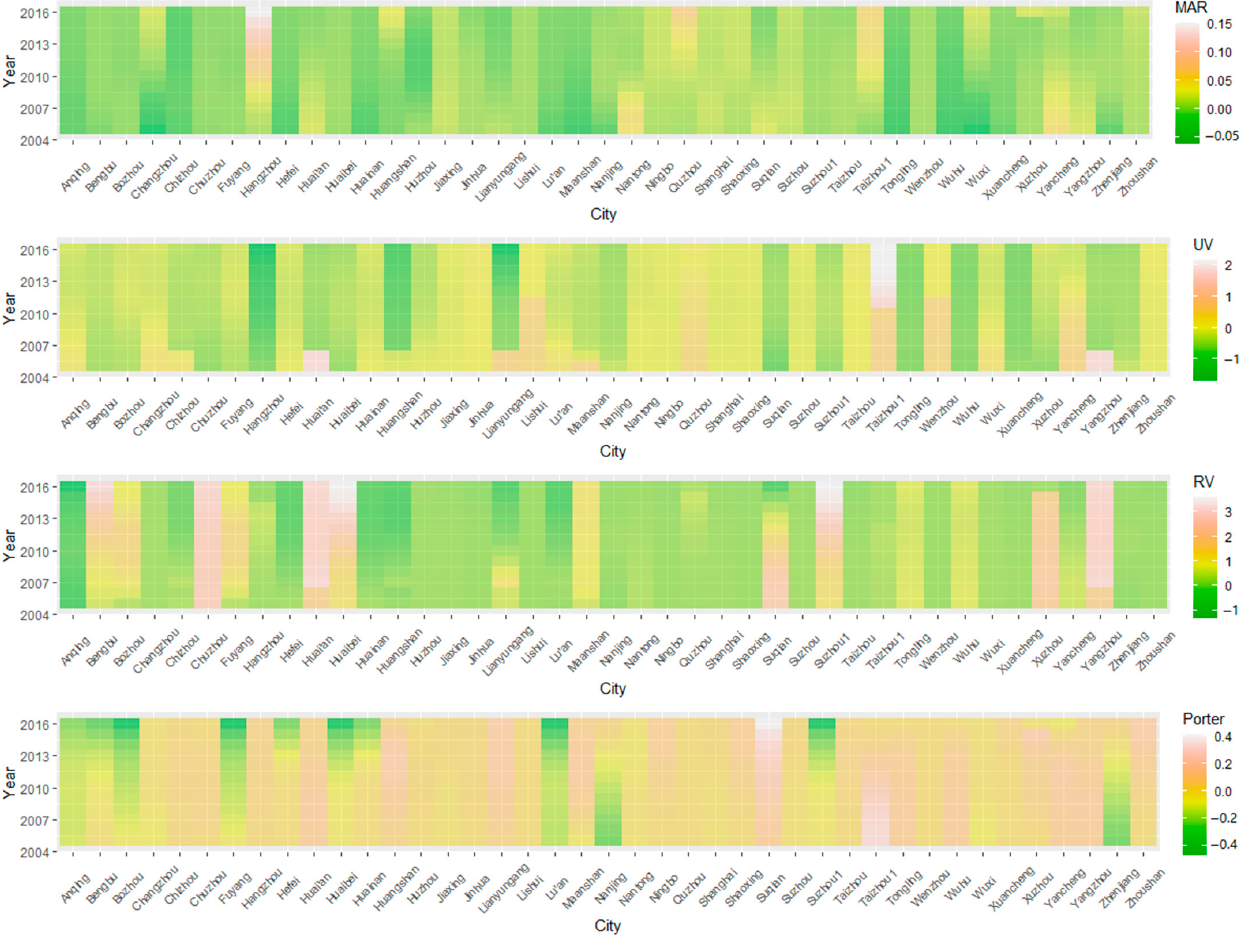
Figure 9. Annual Regression Coefficients of Three Agglomeration Externalities.